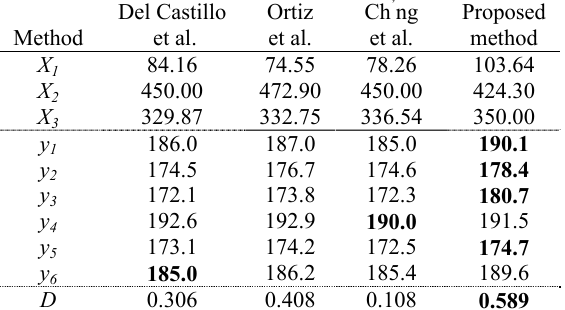
Table 17. Comparison of results for example 2: Methods from literature and approach proposed Method